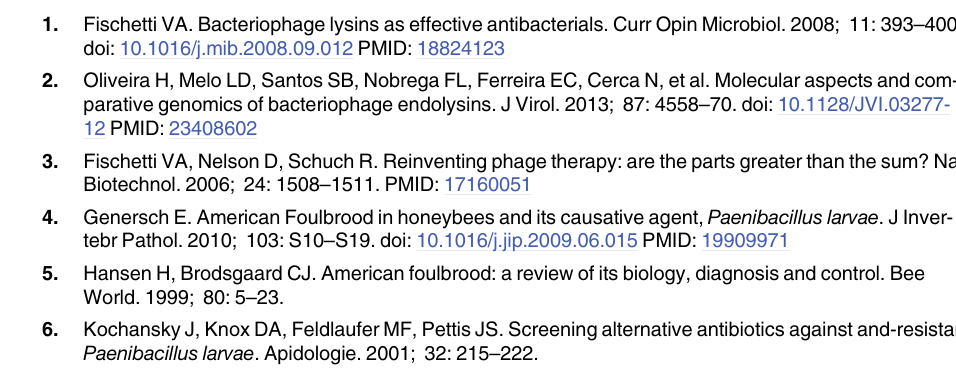
S1 Fig. SDS-PAGE gel loaded with different fractions resulting from PlyPl23 purification. M- Protein marker; 1-Flow through; 2- wash with 20 mM imidazole; 3, 4, 5 – sequentially eluted fractions in 300 mM imidazole. S2 Fig. Evaluation of the stability of PlyPl23, after storage at different temperatures. Activ- ity was tested after storage at 4°C, RT (room temperature) and -20°C for 22